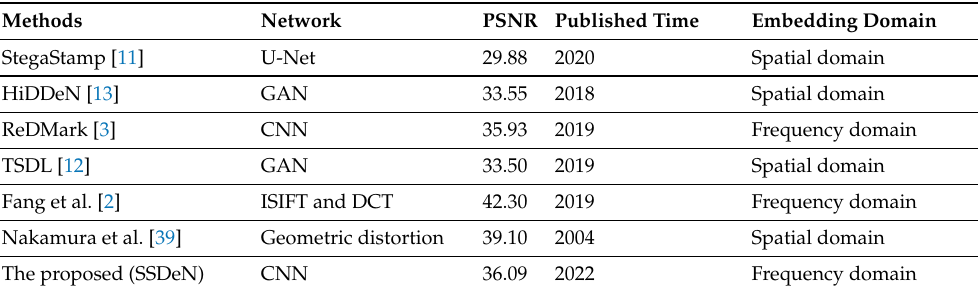
Table 5. Methods